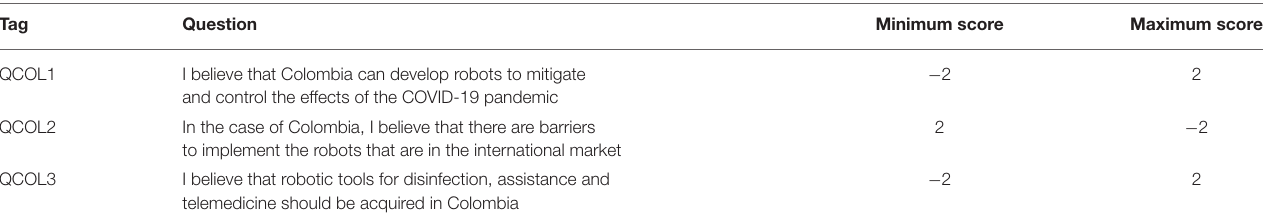
TABLE 3 | Proposed questions to assess the perception of healthcare providers toward medical robotics for COVID-19 in Colombia.